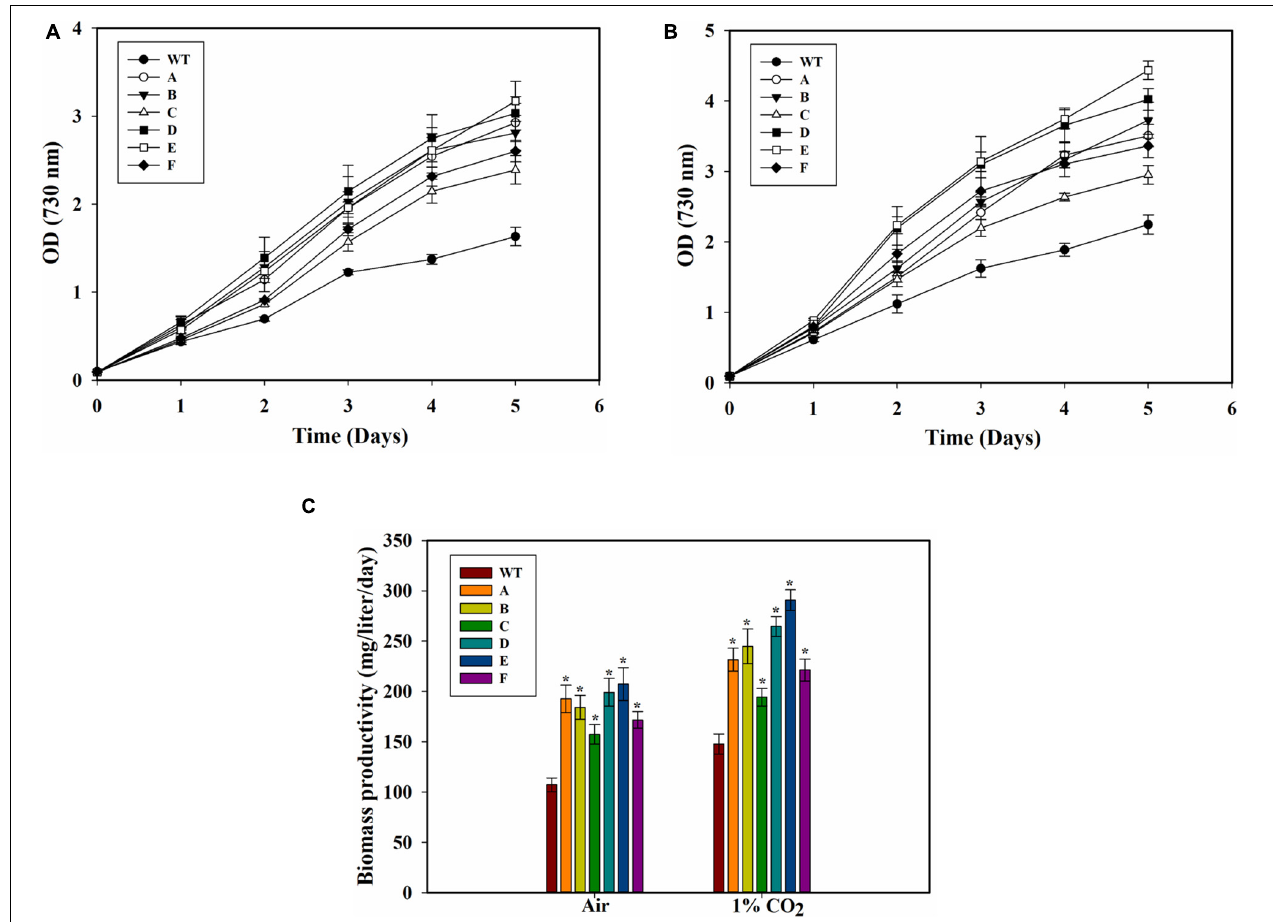
FIGURE 3 | Growth of WT PCC 7002 and transformants. (A) Growth with air bubbling. * p < 0.05 for all strains A to F compared to WT PCC 7002 cells for the same day. (B) Growth with 1% CO 2 bubbling. * p < 0.05 compared to WT PCC 7002 cells for the same day. (C) Biomass productivity with bubbling of air